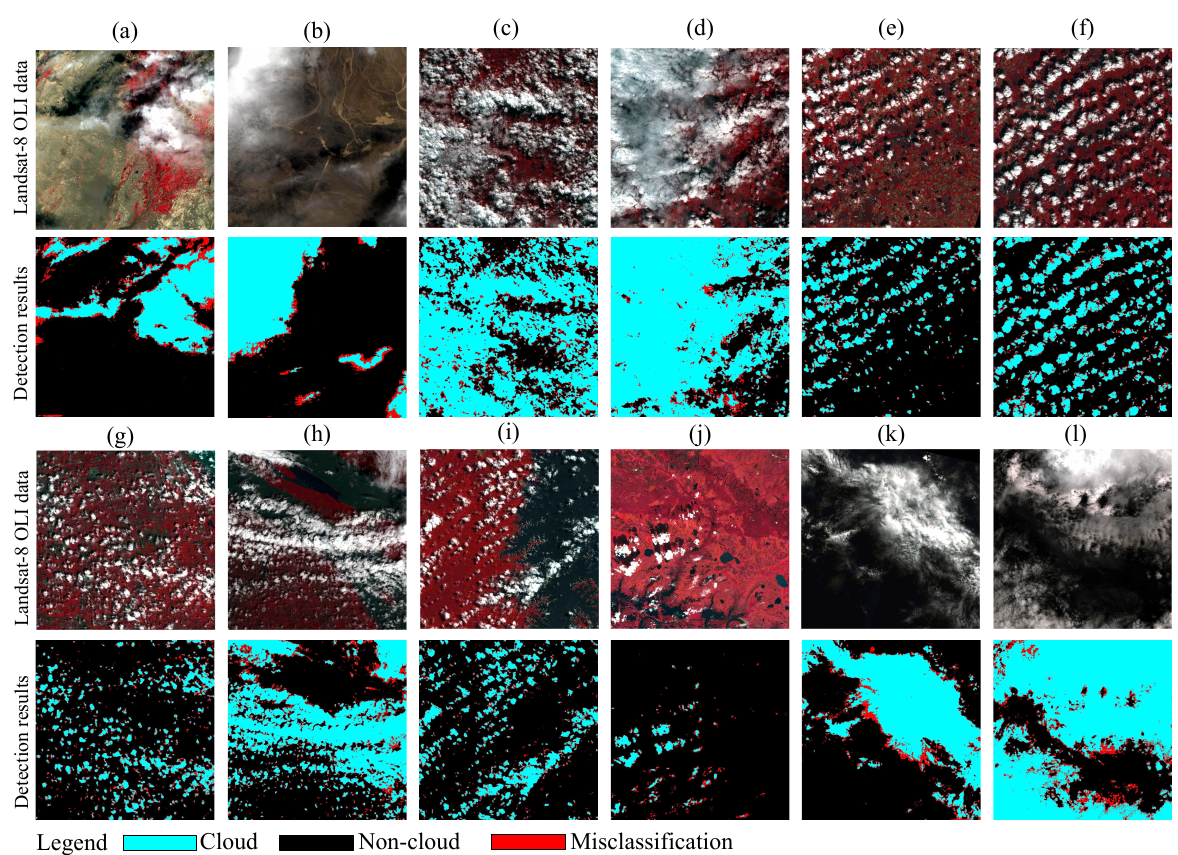
Figure 12. Cloud extraction results (1200 × 1200) of SSCDnet on Landsat-8 OLI data under different land cover types. Where, ( a , b ) are barren/desert areas. ( c , d ) are mountain/plant areas. ( e , f ) are farm- land/villages areas. ( g , h ) are urban/river areas. ( i , j ) are mountain/lake areas. ( k , l ) are ocean